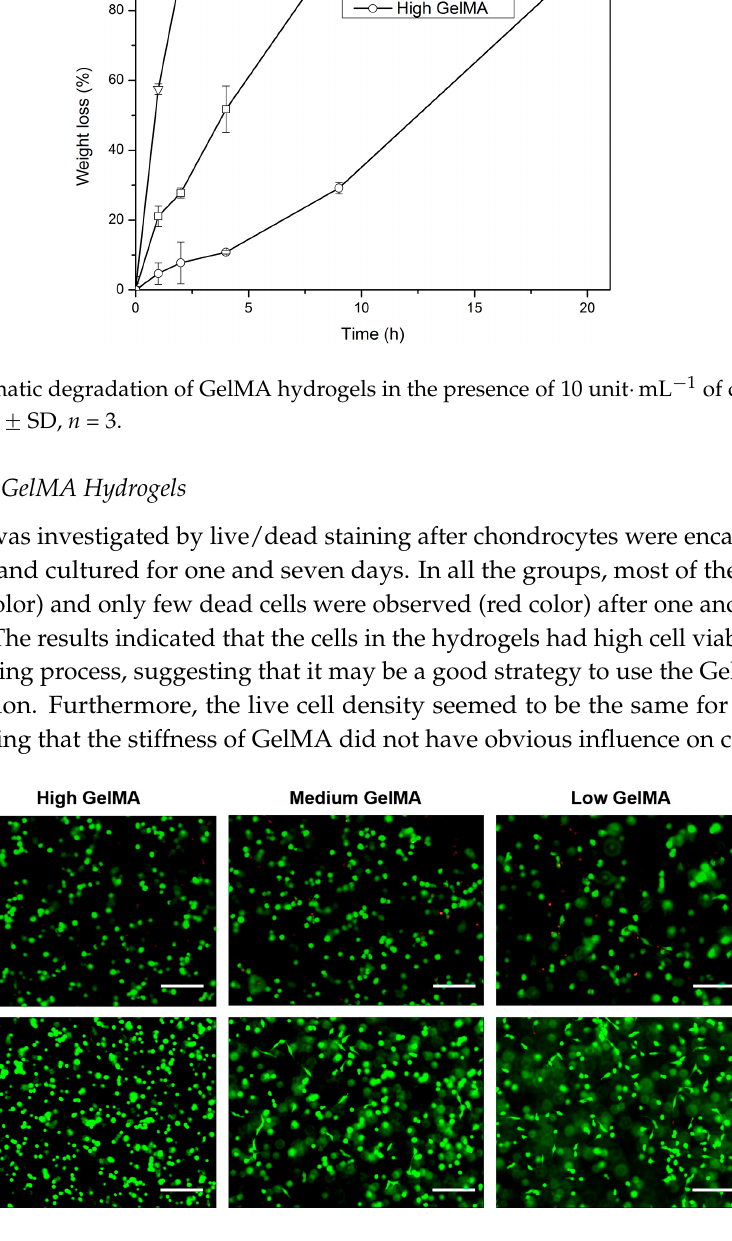
Figure 5. Live/dead staining of chondrocytes cultured in the GelMA hydrogels for one day and seven days. Scale bar = 100 μ m. (Green: live cells; Red: dead cells)